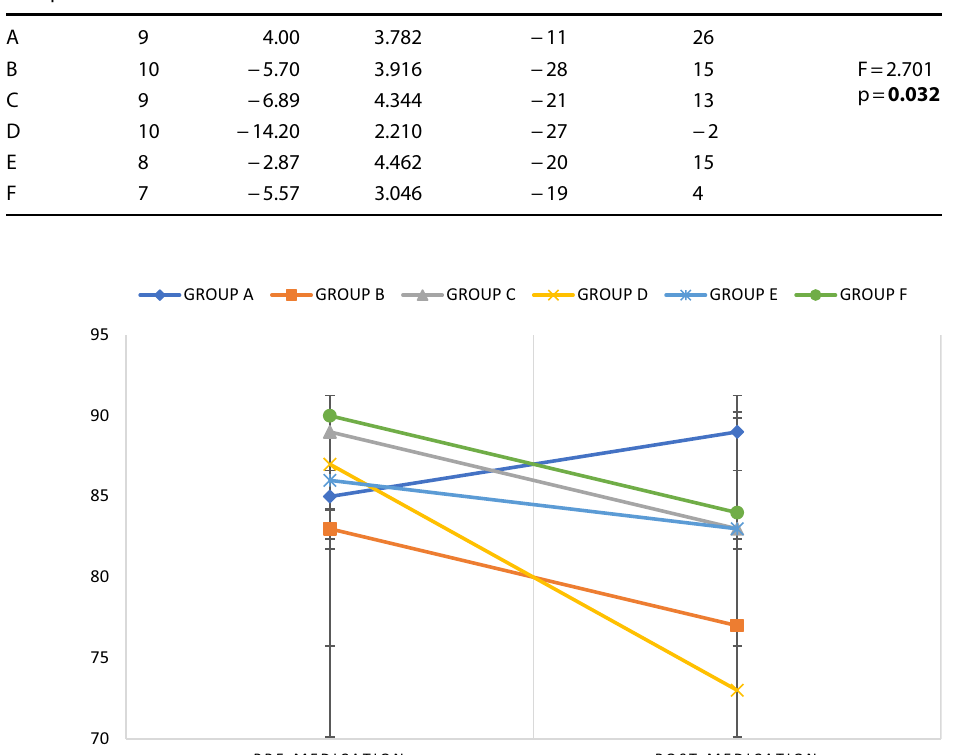
Table 3 Group comparisons in FBS change from baseline